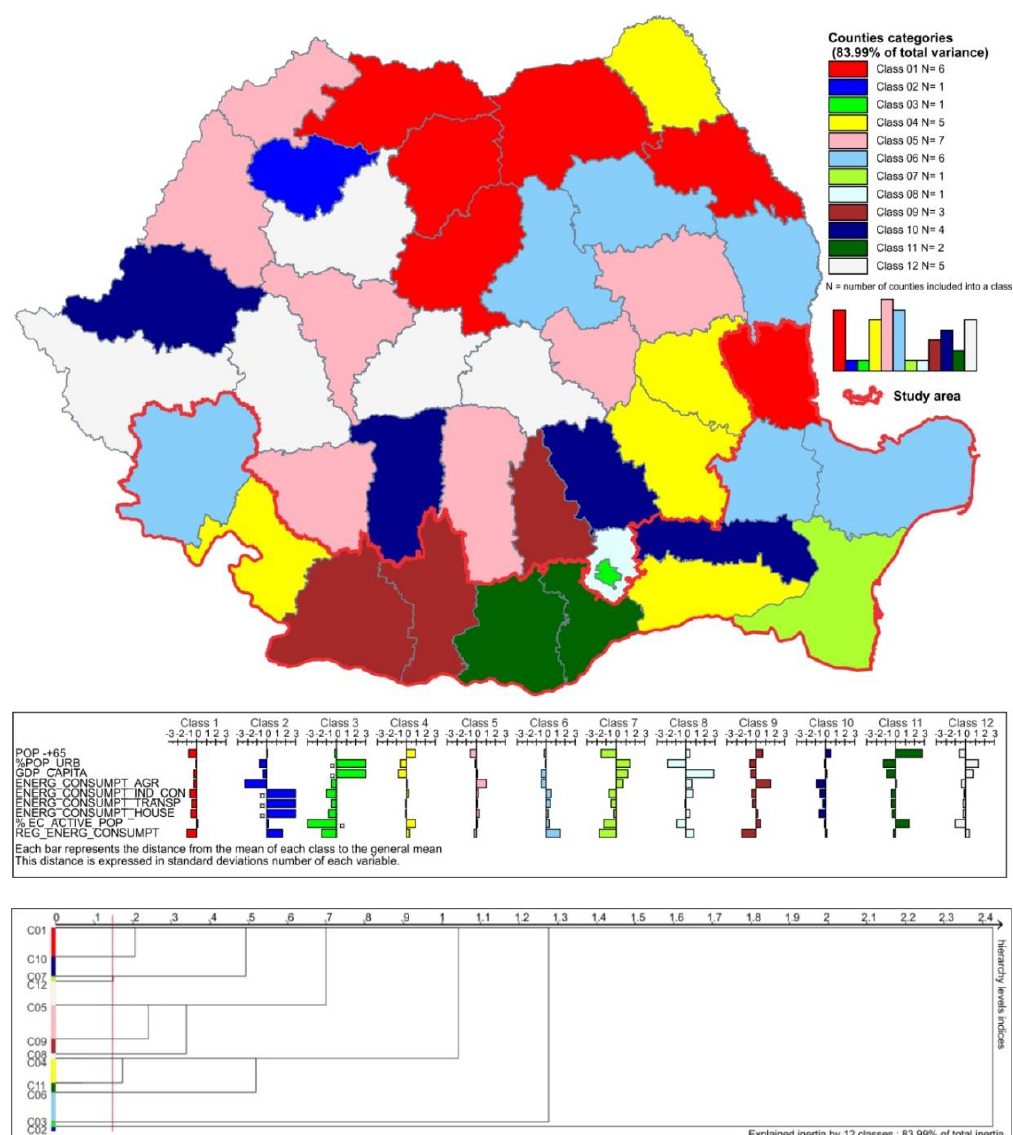
Figure 4. Spatial distribution of the demographic and economic indicators in 2005 (Source: TEMPO Online, National Institute of Statistics), (made with Philcarto, http://philcarto.free.fr).